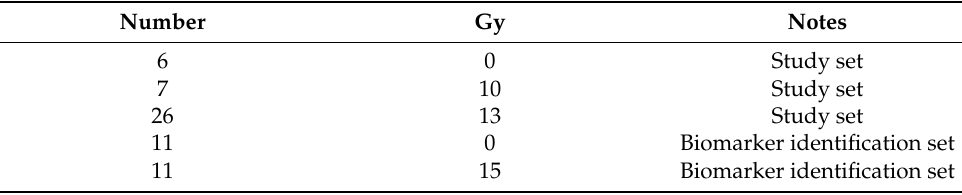
Table 1. Number and distribution of rats used for biomarker analysis.